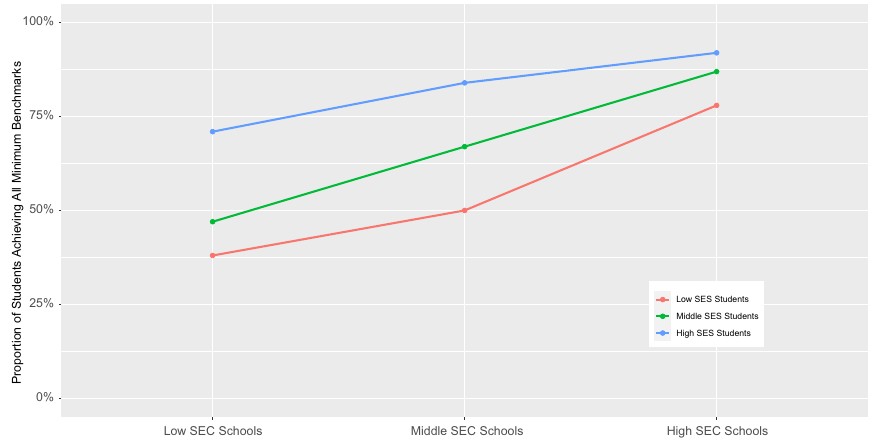
Fig. 2 Proportion of low, middle and high SES students that achieved minimum benchmarks in low, middle and high SEC schools. Low was defined as 1 SD below average, high as 1 SD above